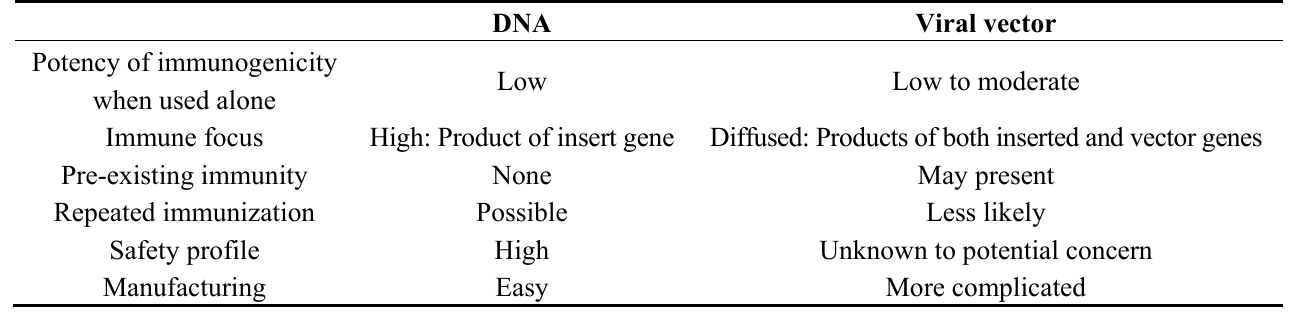
Table 1. Features of DNA vaccines and viral vector-based vaccines.